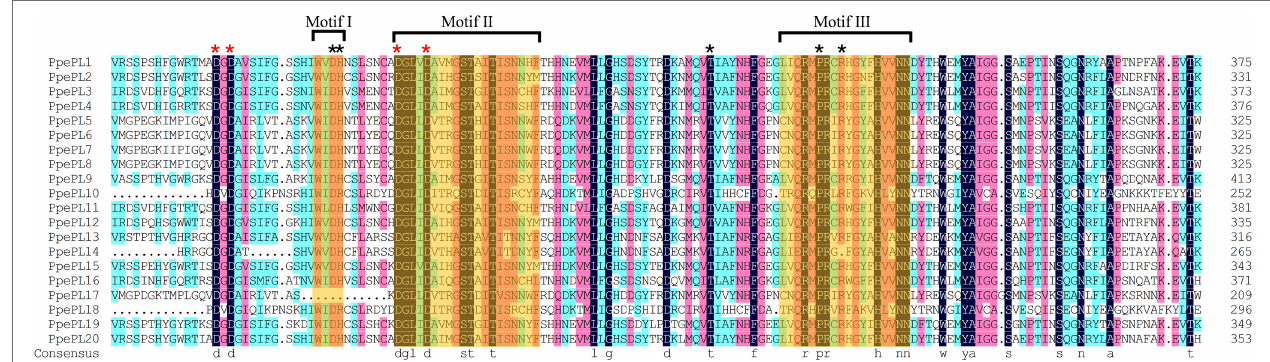
FIGURE 2 | Multiple sequence alignment of Pec_lyase_C domain of PpePL protein. Orange shading indicates three typical conserved motifs of PLs, referred to as motif I, II and III. Different color indicates different similarities (black: 100%, magenta: 75%, blue: 50%). The red asterisk represents the Ca 2+ coordination binding site, and black asterisk represents the active site